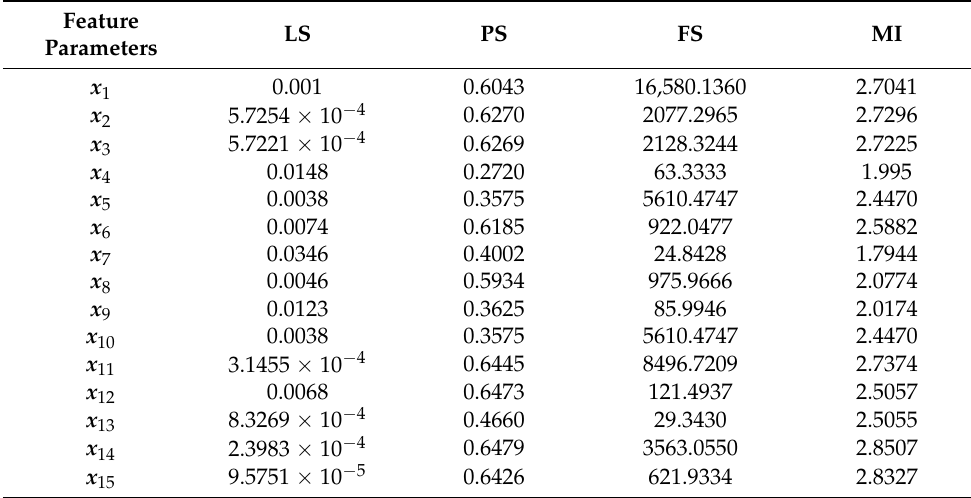
Table 8. Scoring results for the four types of evaluation characteristics.